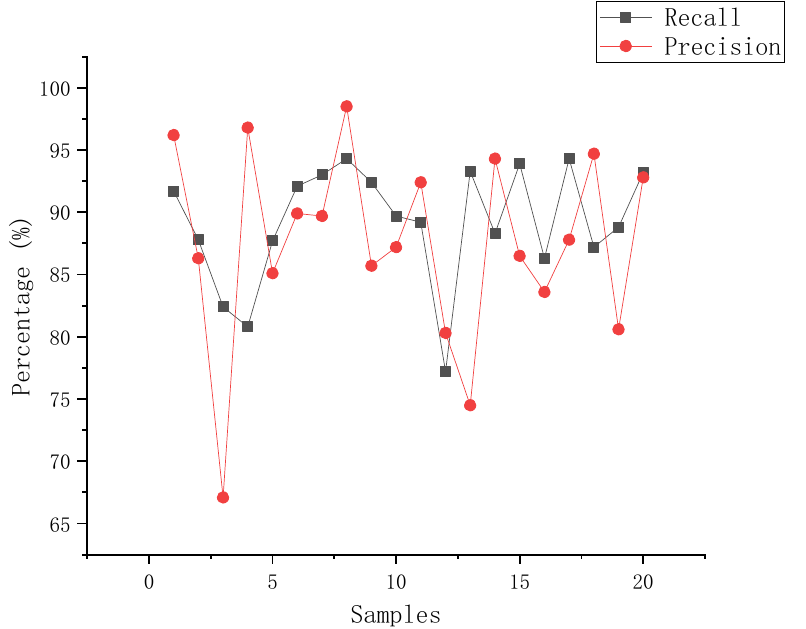
Figure 22. Recall and precision of test samples.